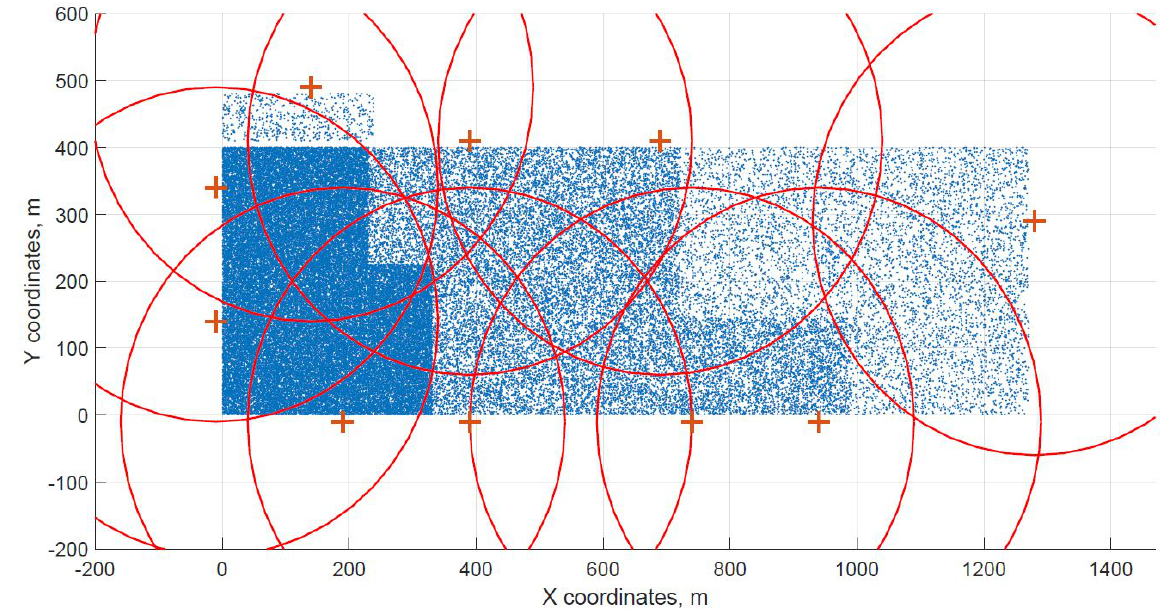
Figure 7. Cuckoo search resulting grid for dataset G.